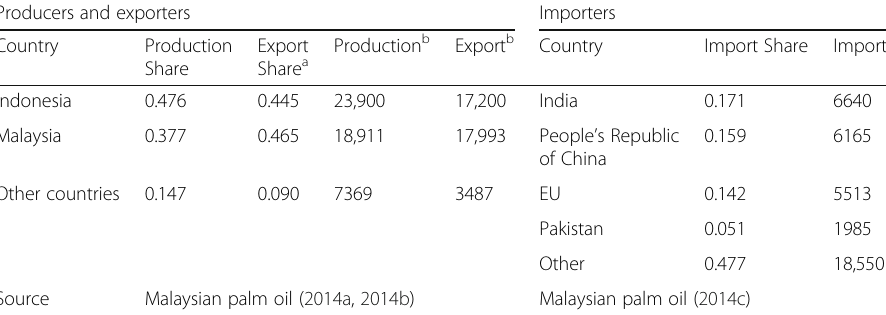
Table 1 World major players of palm oil, 2011 Producers and